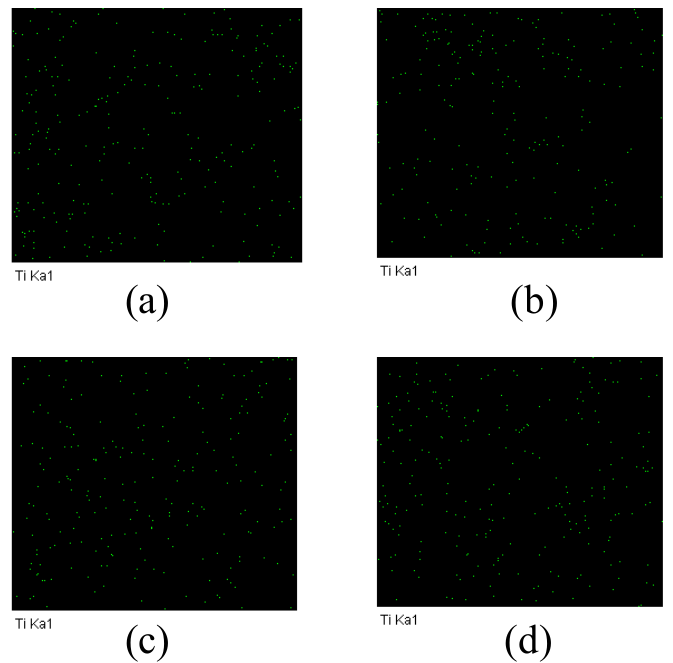
Figure 6. The EDX diagram of the TFC-FO membranes with different amounts of MXene nano-sheets: ( a ) T-2; ( b ) T-3; ( c ) T-4, and ( d ) T-5.